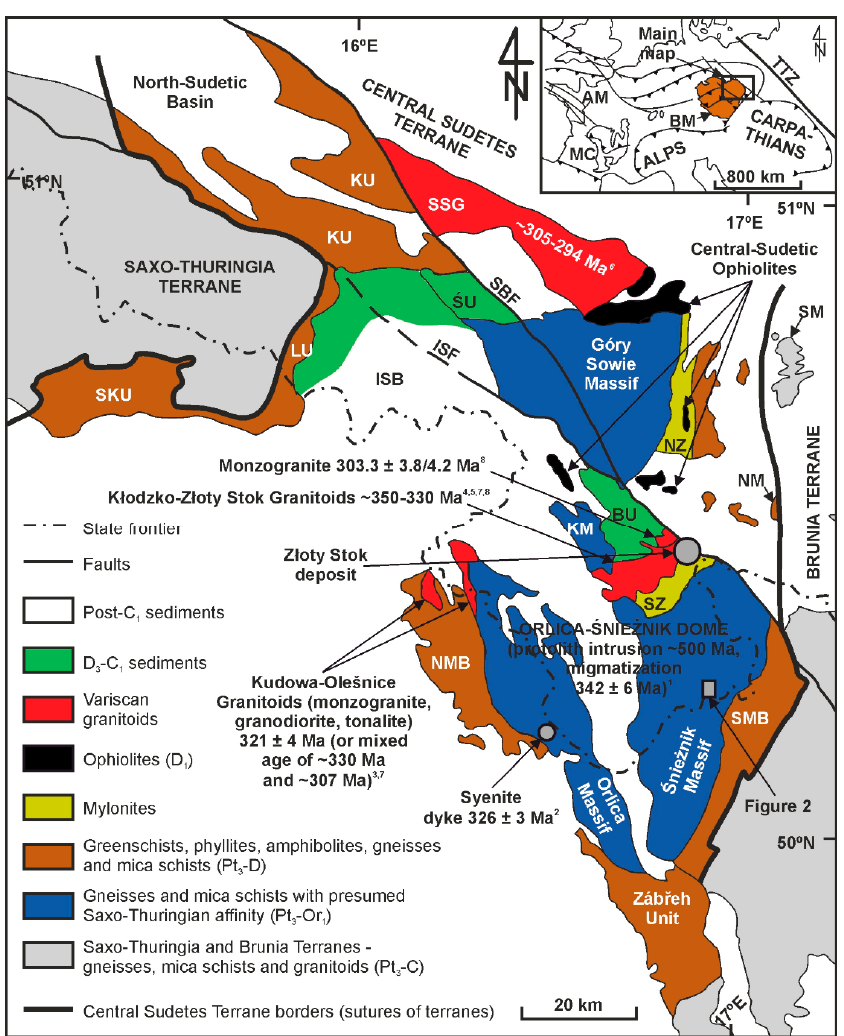
Figure 1. Geological map of the Central Sudetes (modified after Mazur et al. [14]); the inset map shows their location in Europe (modified after Mazur et al. [43]). Ages are from: 1—Turniak et al. [23], 2— Ż ela ź niewicz et al. [41], 3—Mikulski et al. [40], 4—Mikulski et al. [29], 5—Mikulski and Williams [34],